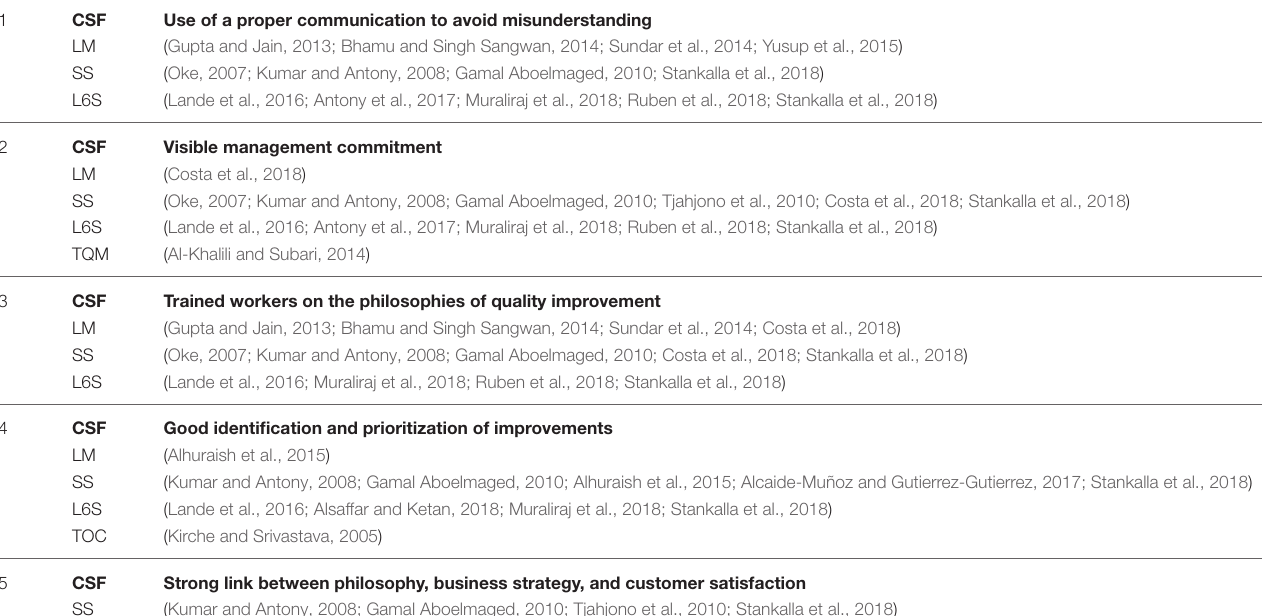
TABLE 2 | Top 10 of CSF identified in the articles